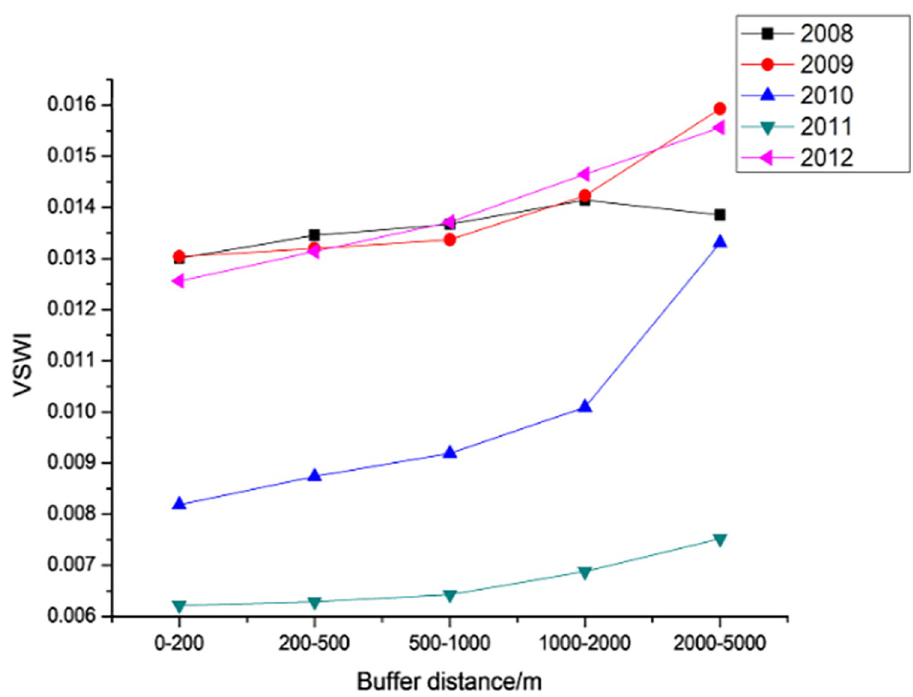
Fig 15. Changes in VSWI by buffer zone of the Jinliwin Expressway from 2008 to 2012.